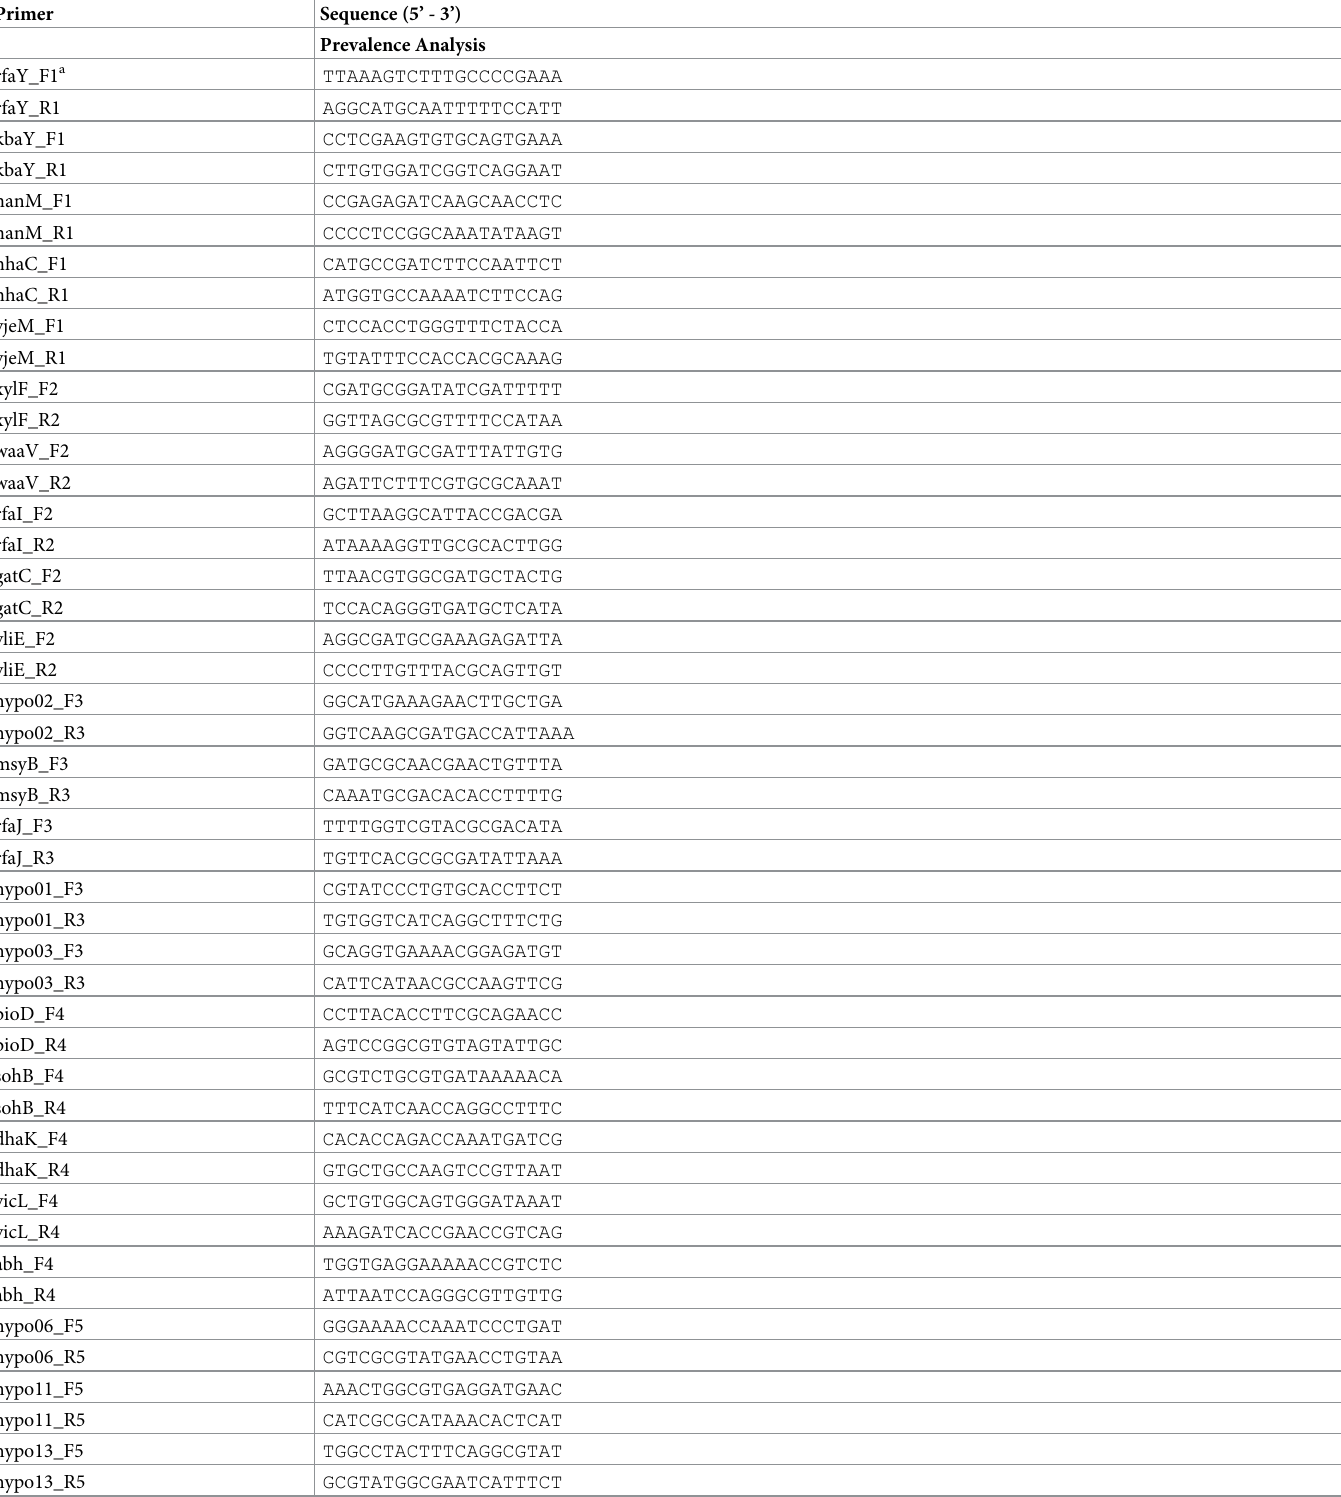
Table 2. Primers used in this study. Primer Sequence (5’ - 3’)